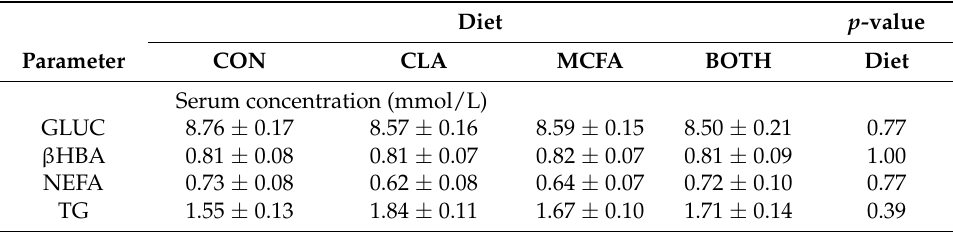
Table 6. Serum metabolite concentrations of piglets on day 3 of lactation after dams fed either a commercial control diet (CON), a diet supplemented with conjugated linoleic acid (CLA), a medium-chain fatty acid (MCFA) product or a combination of both CLA and MCFA diets (BOTH) in late gestation and lactation.